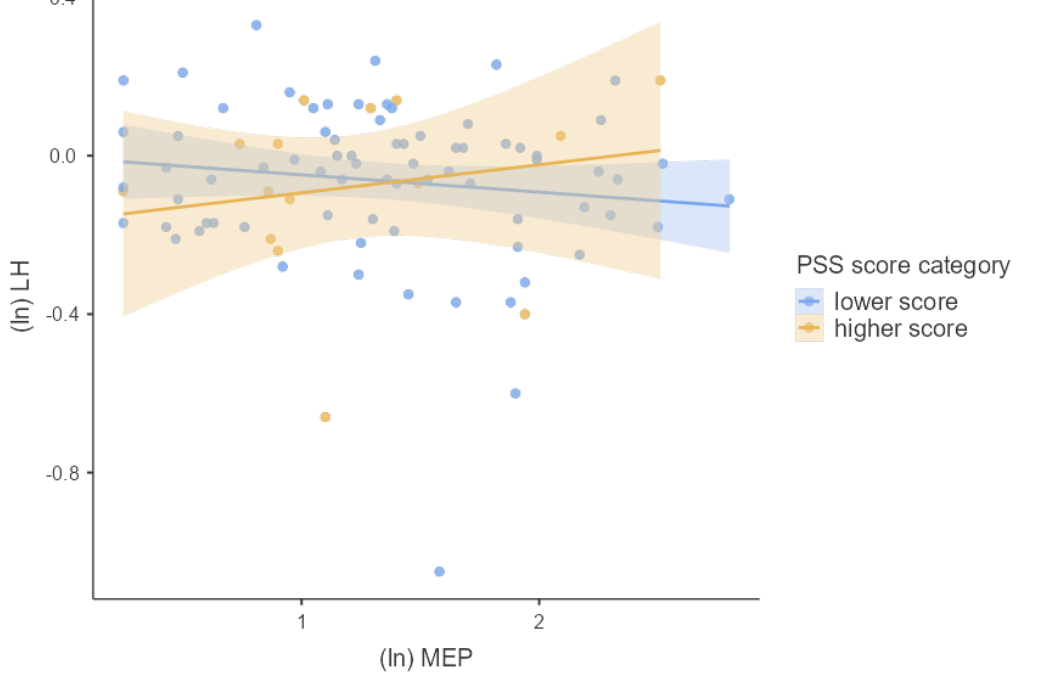
Figure 2. The associations between the concentrations of LH and MEP based on the PSS score category stratification; Legend: ln—log transformation, LH—luteinizing hormone, MEP—monoethyl phthalate, PSS—perceived stress scale.